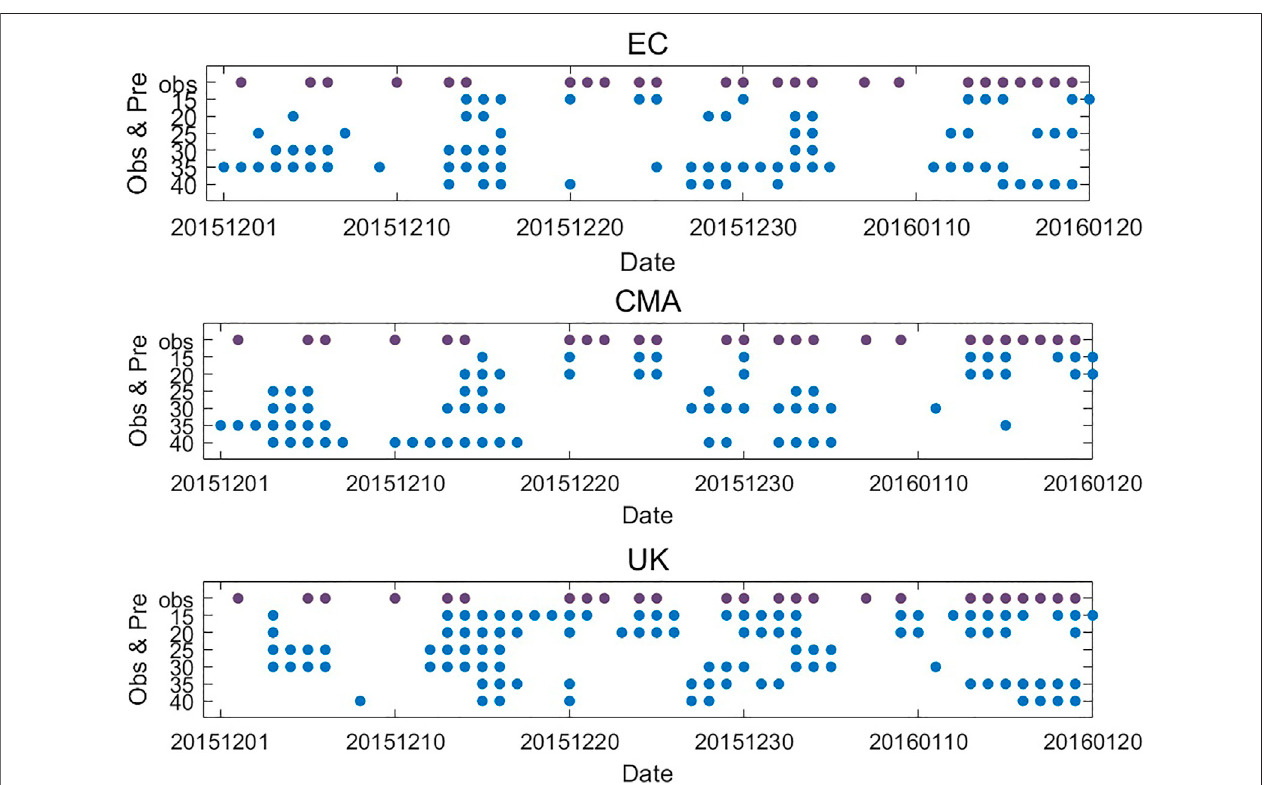
FIGURE 11 | Comparison between the observed pollution processes and the LSTM-predicted pollution periods (December 1, 2015 – January 20, 2016). (Note: Purple dots indicate the observed pollution period (December 1, 2015 – January 20, 2016).) The three sets of graphs show the predicted pollution period by ECMWF (top), CMA (middle), and the U.K. (bottom) models with different period validity ( y